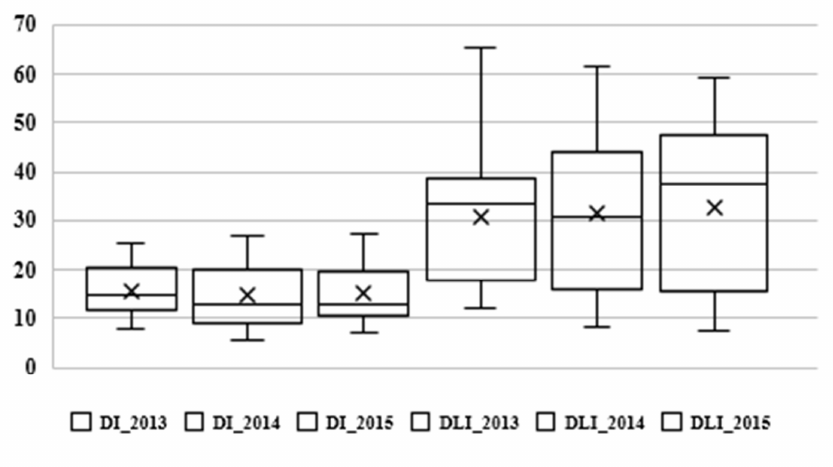
Source: own calculations based on Rosstat (2017), UniSIS